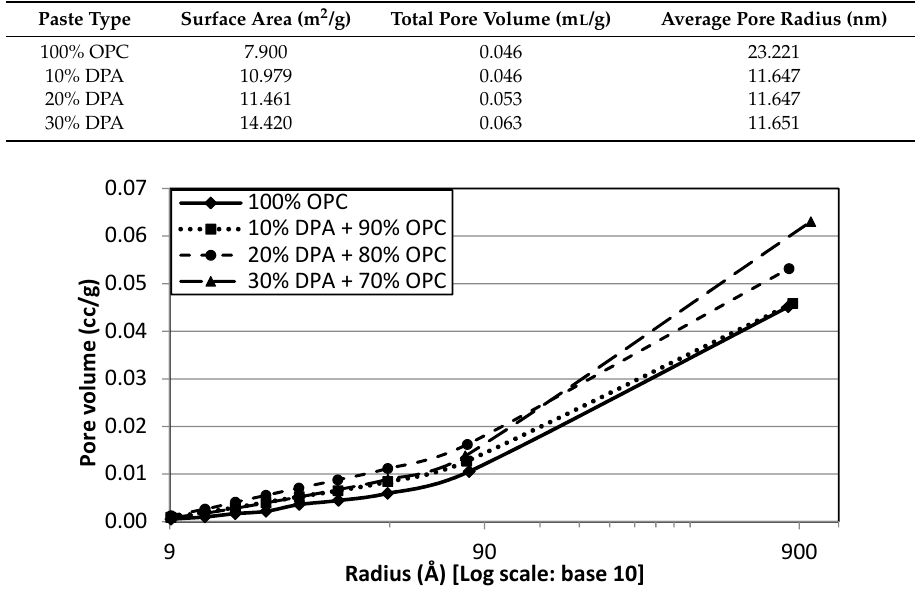
Figure 8. Pore volume distribution in all mixtures.